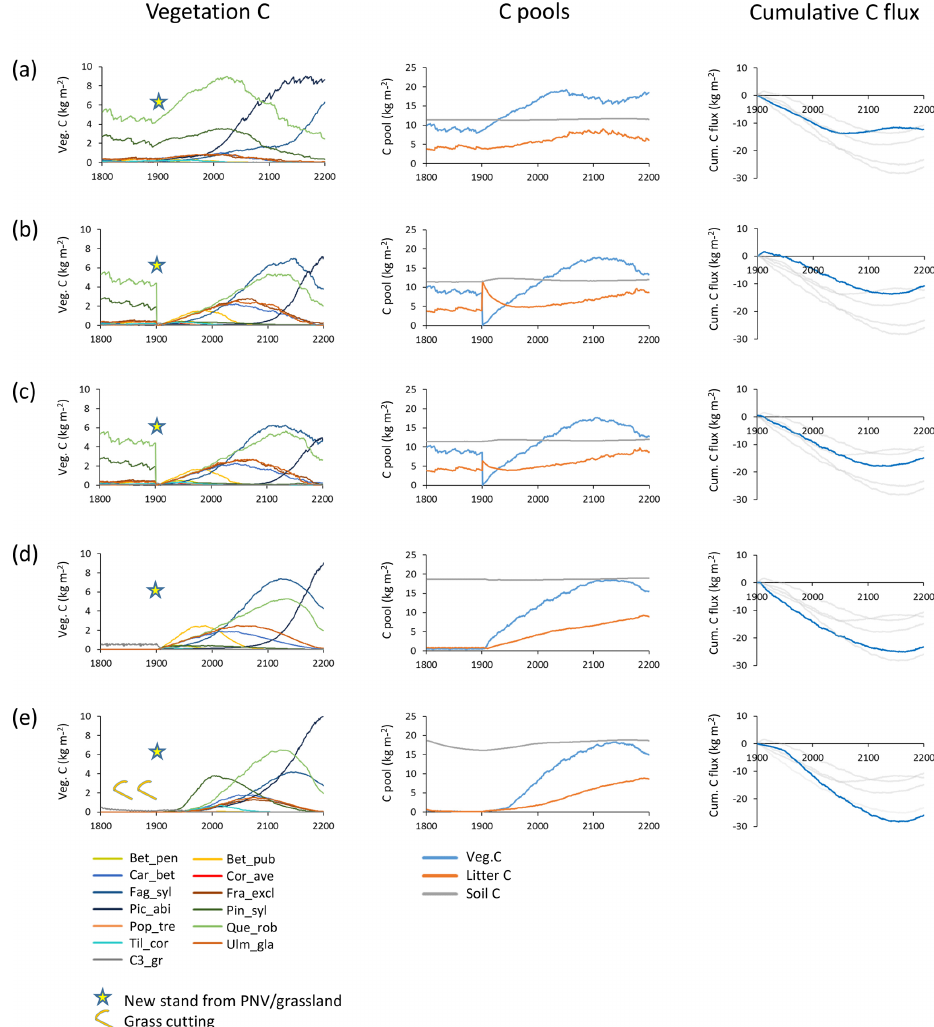
Figure 2. Examples of different histories and initialisations of modelled forest stands at a southern Swedish site (55.75 ◦ N, 13.75 ◦ E) with CRU-NCEP climate (recycled 1986–2015 climate after 2015). Disturbance and fire were turned off in the managed forest stands. Vegetation carbon, carbon pools (vegetation, litter and soil), and cumulative total carbon flux (negative values correspond to an uptake from the atmo- sphere) are shown for forest stands created in 1901 from PNV or grassland. (a) PNV stand with 25 patches cloned, keeping age and species structure from the spin-up period intact. (b) Clear-cutting of PNV stand. Harvested wood and branches left as litter. Succession from bare ground. (c) Clear-cutting of PNV stand. Harvested wood and part of branches removed. Succession from bare ground. (d) From grassland with one patch. (e) From intensively cut meadow with one patch, 100% of leaves cut each year in 1800–1900. Species and PFT